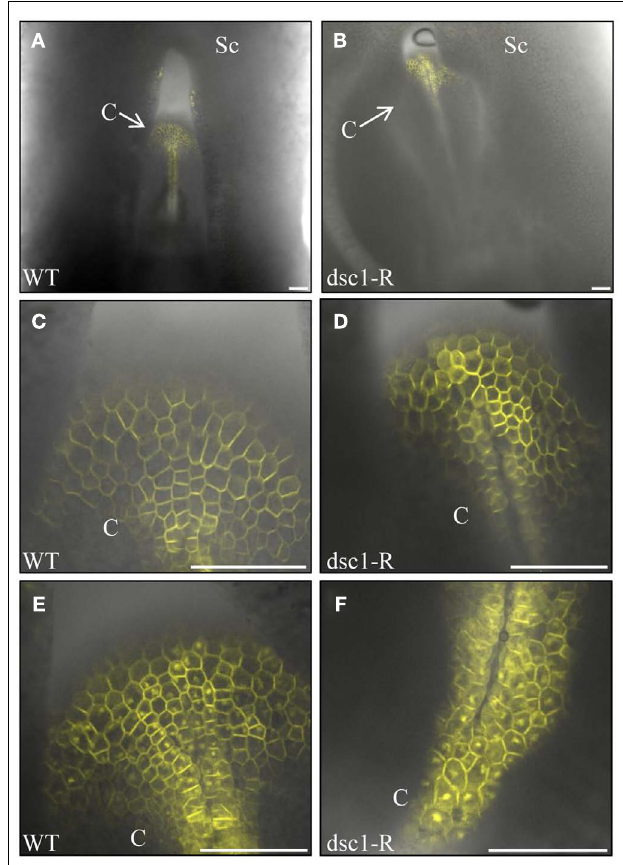
FIGURE 8 | PINFORMEDla (PINla) endomembrane transport is not disrupted in dscl-R mutant embryos. (A) YFP-tagged PPSTla preferentially localizes at the plasma membrane in mock-treated (A,C) non-mutant and (B,D) dscl-R mutant embryos.The coleoptiles imaged in (C,D) are magnified from (A,B) , respectively.YFP-tagged PIN la accumulates internally after Brefeldin A (BFA) treatment of embryos in both ( E ) non-mutant and (F) dscl-R mutant embryos. No difference in the shape or number of BFA bodies in non-mutant and dscl mutant embryos is observed. DAP, days after pollination; C, coleoptile; Sc, scutellum; BFA, Brefeldin A. Scale bars represent